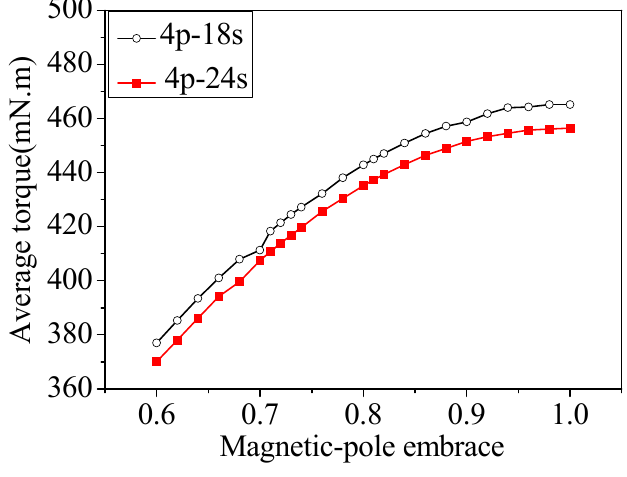
Figure 4. The trend of average torque with the magnetic-pole embrace